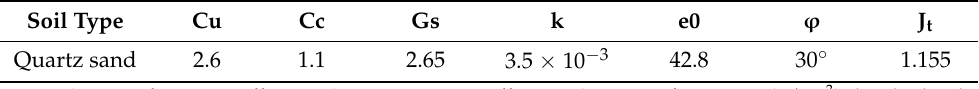
Table 2. Properties of the tested